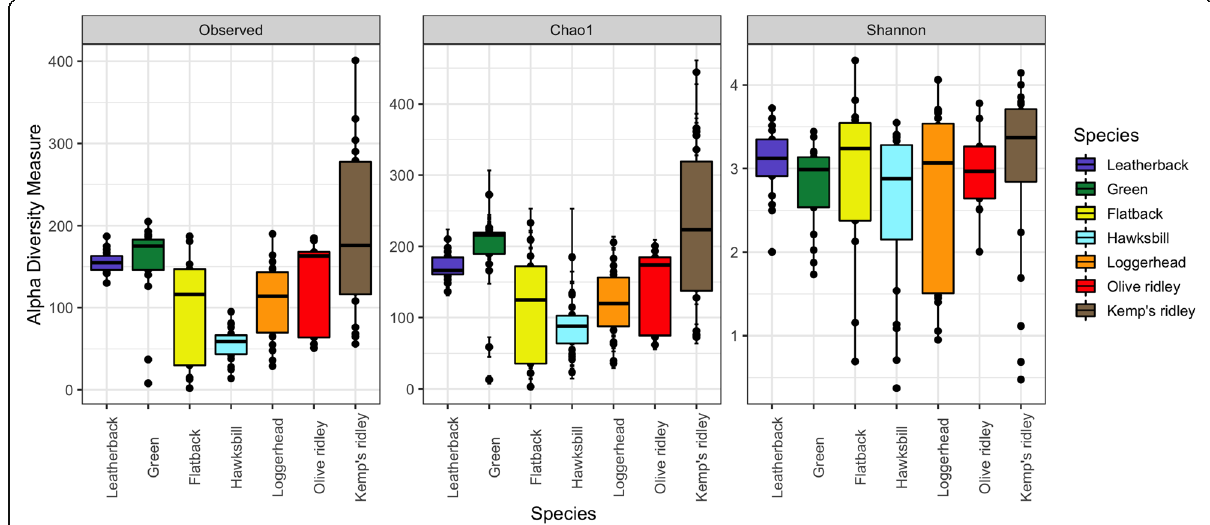
Fig. 2 Alpha diversity measures across all species. Individual points and brackets represent the richness estimate and the theoretical standard error range associated with that estimate, respectively. Within each panel, the samples are organized into species, and a boxplot is overlaid on top of this. The mean microbial diversity estimate using Shannon ’ s diversity index did not differ significantly among all samples ( p = 0.28). However, there were significant differences between samples as measured by Observed ( p < 0.001) and Chao1 (p < 0.001)